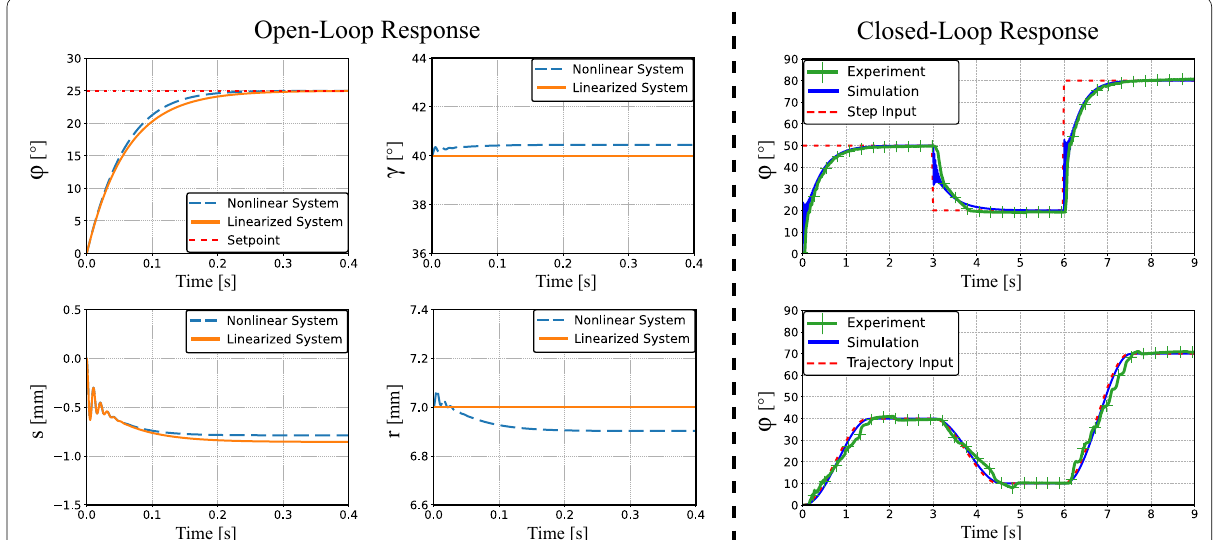
Fig. 5 Dynamic response of a FREE. Numerical solution for simulated open-loop response based on the original and the linearized model (left). The simulation results suggest insignificant changes in radius r and winding angle γ of the FREE before and after pressurization. Closed-loop response to a PID controller with step and trajectory following inputs (right). Experimental data is compared with the simulation results, and the trajectory-based controller produces a smoother response. All results correspond to a FREE with constant geometric properties Ŵ = 40 ◦ , L = 11 cm, and R = 0.7 cm, external forces and moments F l = F gravity and M l = 0 , stiffness k e = 10110 N/m, and k t = 0.086 N/rad, and damping constants c e = 5 N-s/m, and c t = 0.005 N-m-s/rad that was controlled with a PD controller ( K p = 32000 and K d = 1200000 Pa/rad-s). See our project repository for the codes used in our simulations and experiments: https:// github. com/ soheil- h/ FREE.